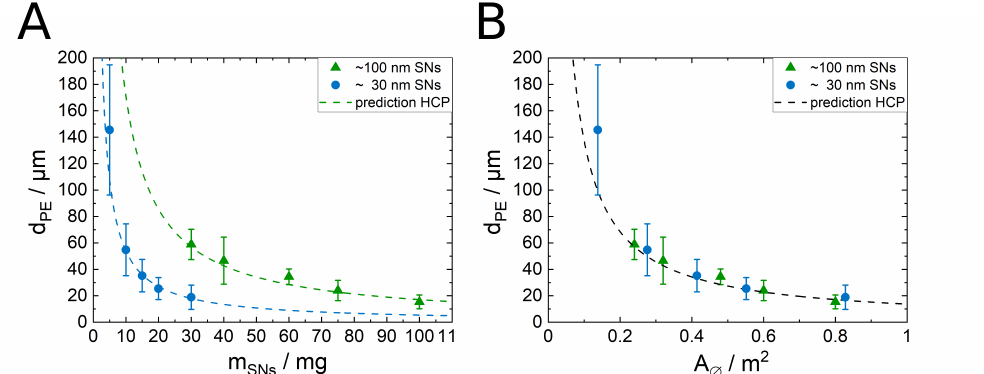
Figure 2. ( A ) Sauter mean diameter d PE of emulsion droplets prepared with SNs only ( V PE,tot = 12.55 mL, 20 vol%, oil type 1-dodecene) as a function of the amount of SNs. The plot shows the typical reciprocal behavior of the particle mass. The dashed lines are completely indepen- dent predictions using Equation (1) and assuming a hcp ( s = 0.907). These predictions describe the data sufficiently (average deviation less than 10%). ( B ) Same measured Sauter mean droplet diameter as shown in ( A ) plotted over the total particle cross-section A ∅ of the applied